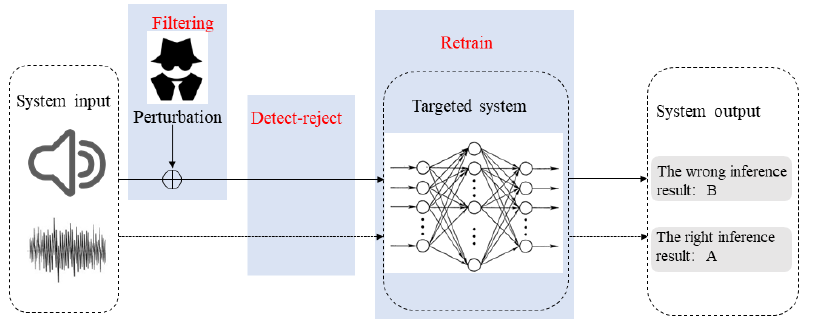
Figure 3. The general method of defense including filtering, detect–reject, retrain.